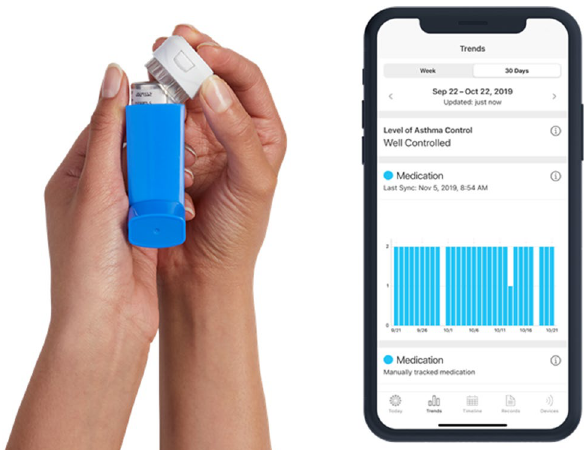
Figure 1. A small FDA-cleared electronic medication monitor (EMM) is attached to the user’s controller medication inhaler to capture the date and time of use. Data from the EMM is then transferred wirelessly via Bluetooth to a paired smartphone app providing feedback, insights and medication